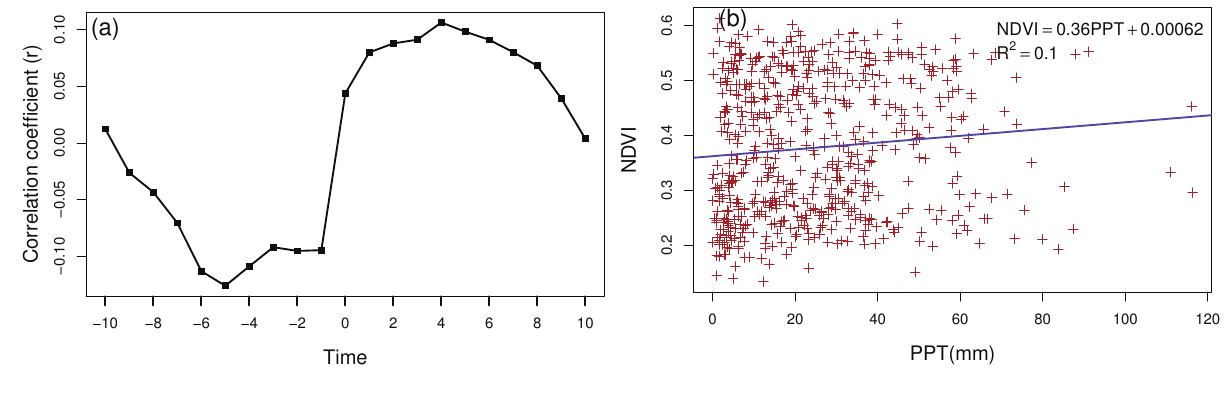
( a ) Twenty-five-year (1982–2006) averaged correlation coefficients between NDVI and different time lags of PPT; ( b ) The scatter plot between 15-day composited GIMMS NDVI and 15-day totals PPT in 25-years